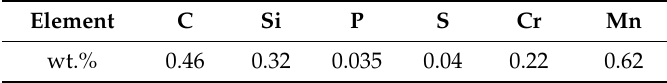
Table 1. Chemical composition of ASTM 1045 steel (mass fraction, %).